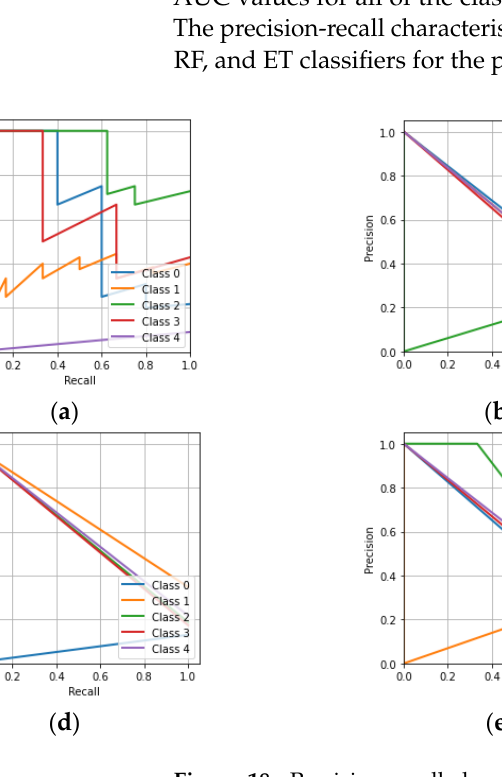
Figure 18. Precision-recall characteristics for the phase-only image dataset: ( a ) CNN; ( b ) KNN; ( c ) MLP; ( d ) DT; ( e ) RF; ( f ) ET. ( c ) MLP; ( d ) DT; ( e ) RF; ( f )